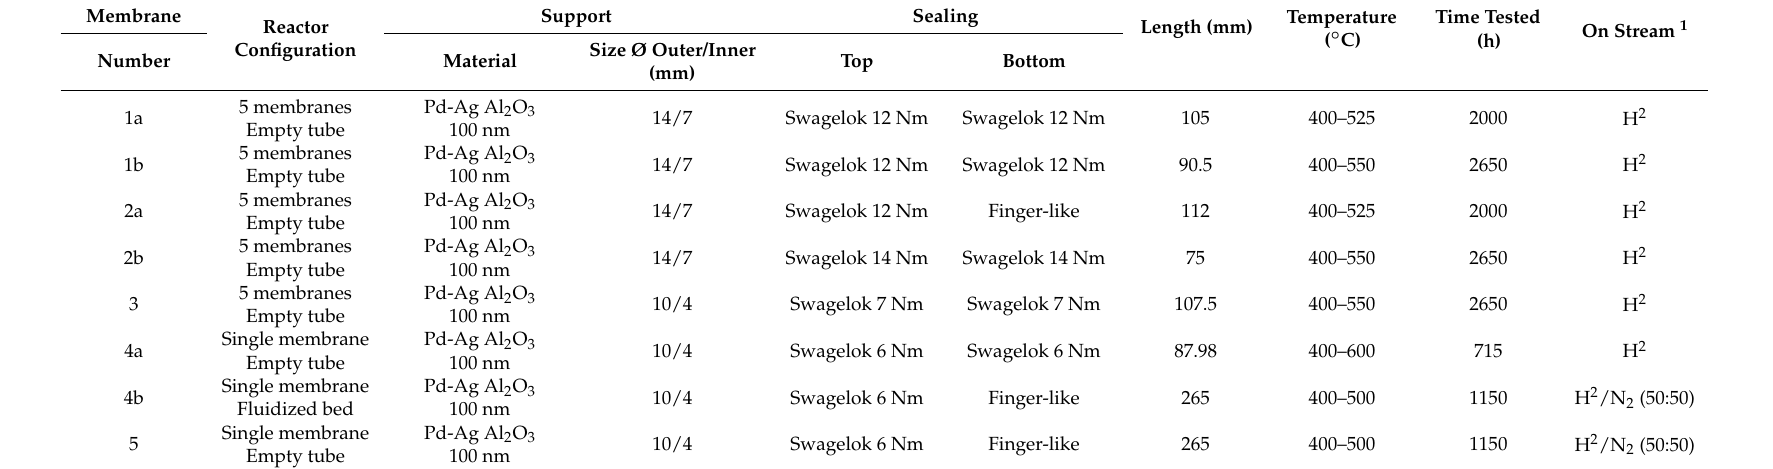
Table 3. Details of membranes and conditions used in this